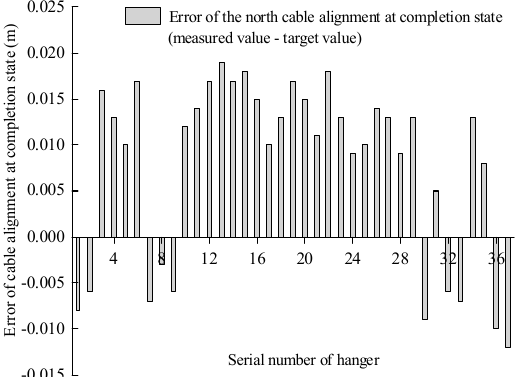
Figure 20. Comparison of the final cable